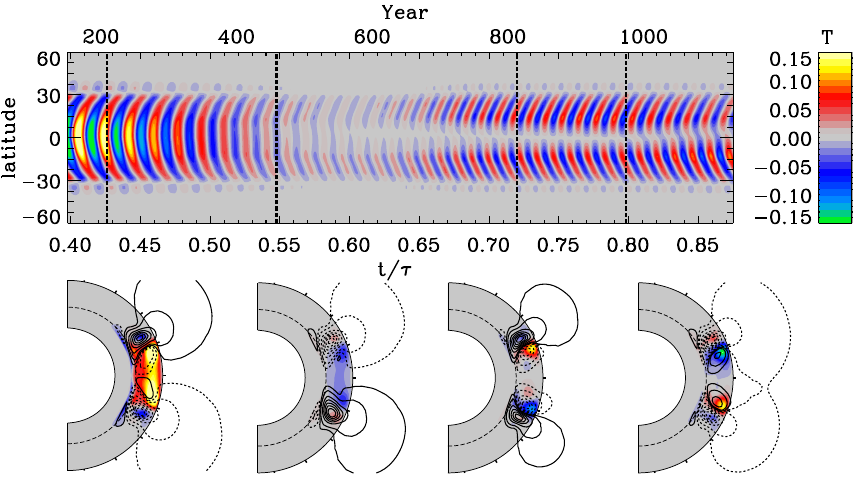
Fig. 9. Snapshot of an epoch of a grand maximum followed by a grand minimum for solution run 4. Top panel shows the toroidal magnetic fi eld in a time-latitude diagram extracted at r / R = 0.85. The bottom panel shows four meridional planes snapshots extracted from the simulation at times indicated by the dashed lines on the upper panel. The color scale encodes the toroidal magnetic fi eld, and poloidal fi eldlines are plotted as solid (dashed) lines for counterclockwise (clockwise) orientation.